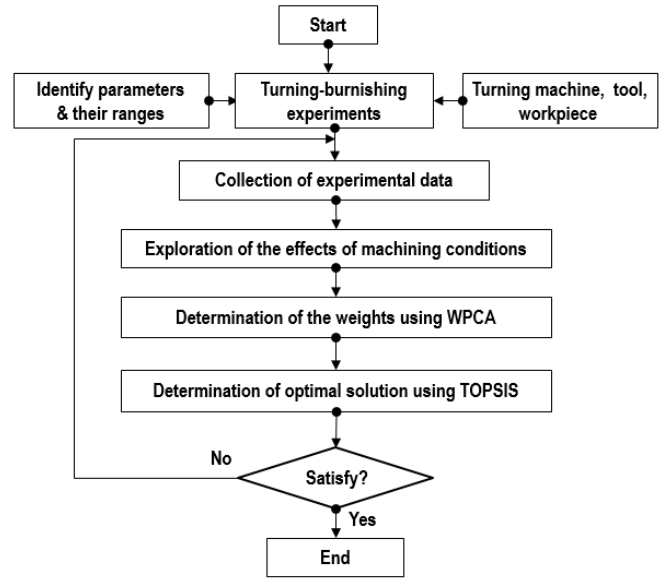
Figure 2. Systematic optimization procedure.